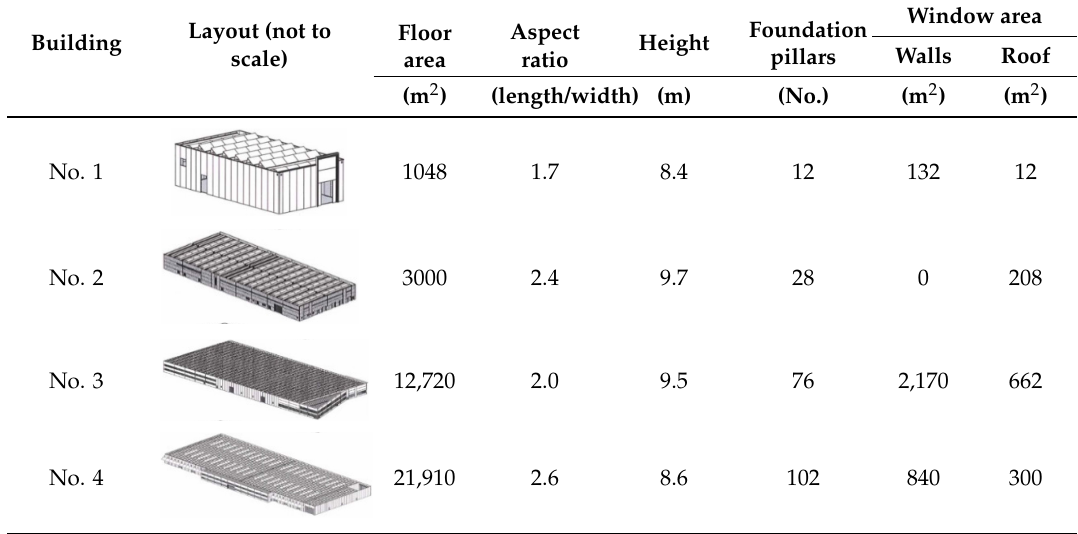
Table 1. Layout and main properties of the four selected